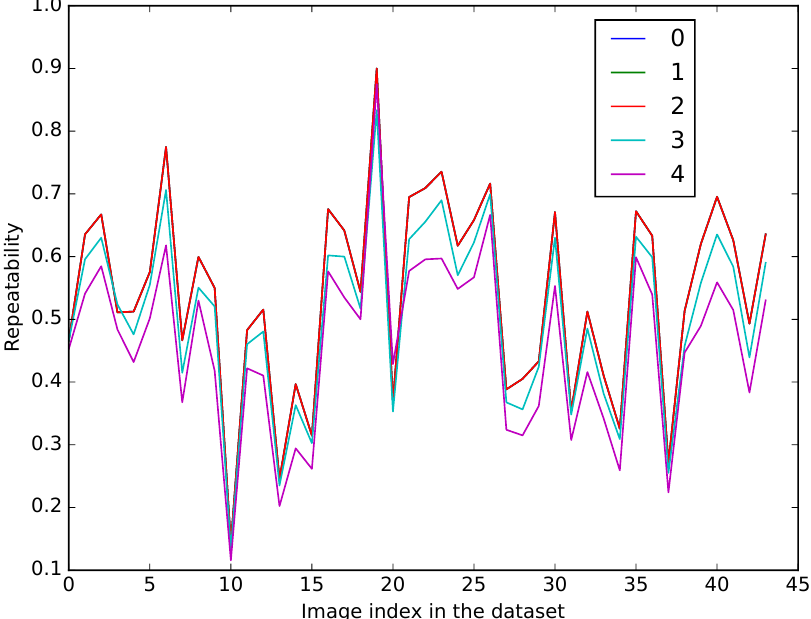
Figure 6. Detector parameters tuning: repeatability for different minimal distances (in pixels) ccording to each image pair in the